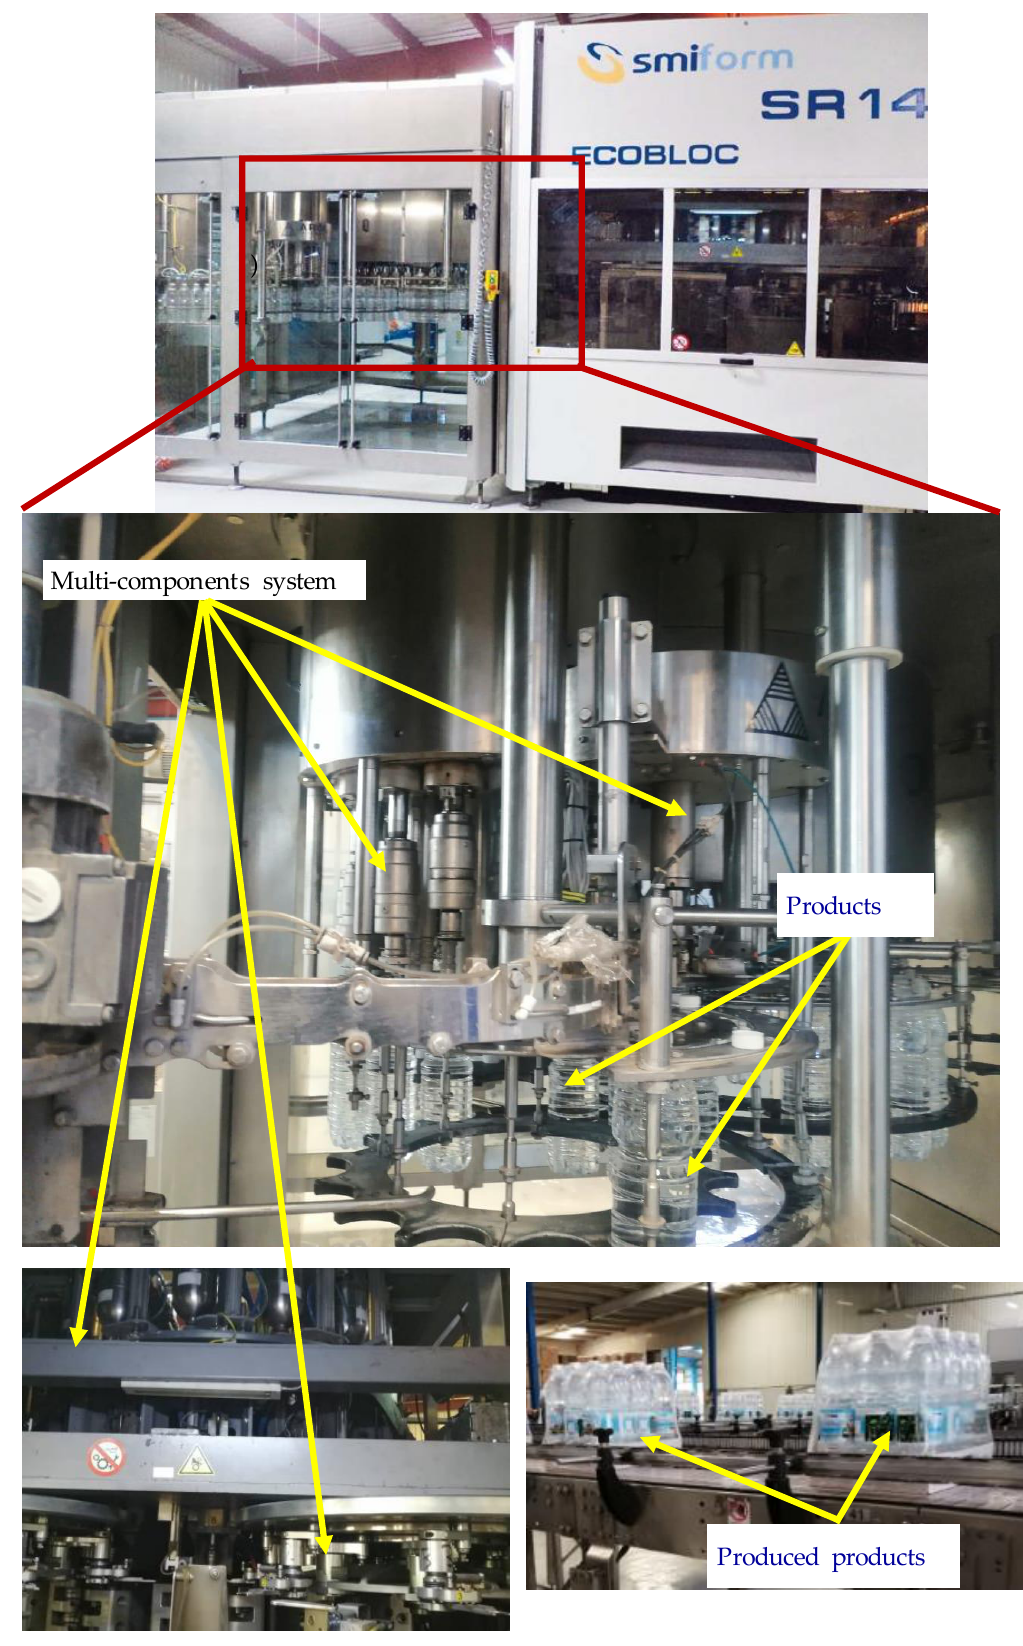
Figure 3. Filling process in the selected company.